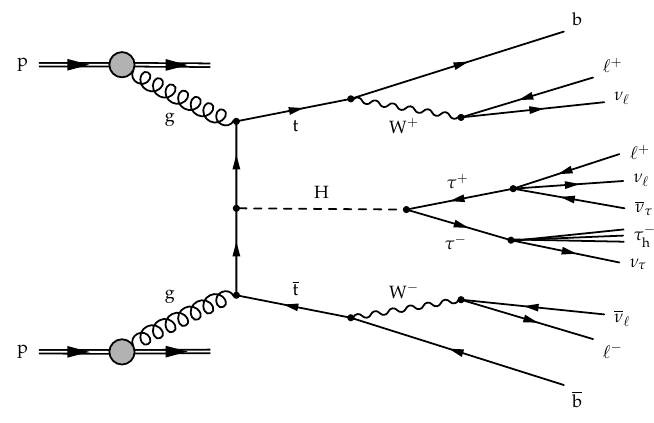
Figure 1 . An example of a Feynman diagram for ttH production, with subsequent decay of the Higgs boson to a pair of (cid:28) leptons, producing a (cid:12)nal state with two same-sign leptons and one reconstructed hadronic (cid:28) lepton decay ( (cid:28) h